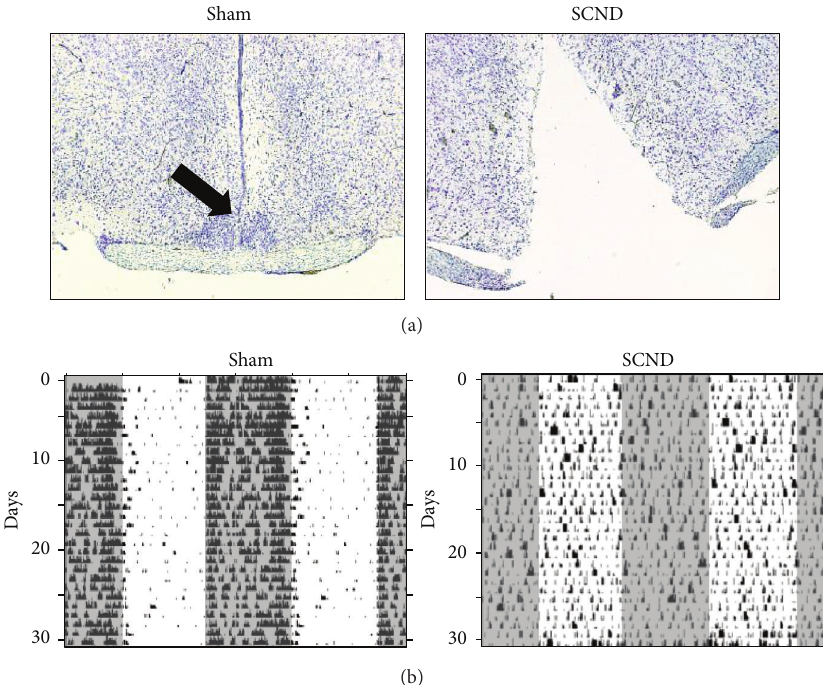
Figure 1: Histological and general locomotor analysis after induction of the bilateral electrolytic lesions of the SCN in mice. (a) The SCN of the mice was destroyed by bilateral electrolytic lesions and complete SCN destruction was ascertained by a postmortem histological analysis. Representative pictures of the staining in sham-operated mice (Sham) and mice with disrupted SCN (SCND) are shown. The arrow indicatestheSCNarea.(b)GenerallocomotoractivityofmicehousedunderLD12 : 12conditionswasrecordedandrepresentativedouble-blot actograms of the drinking behavior of the mice during 30 days are shown. The black dots indicate the mouse locomotor activity. Horizontal open and solid bars indicate day and night, respectively. Please note that the drinking behavior (usually accompanied by food intake) became arrhythmic in mice with disrupted SCN